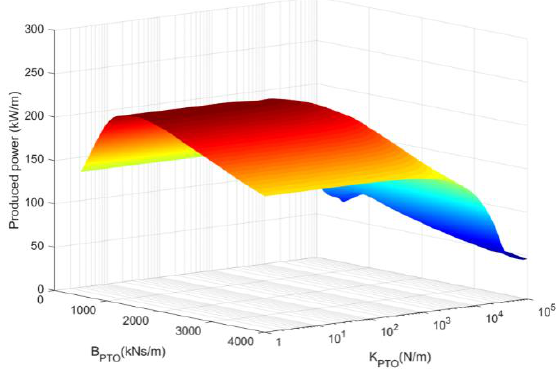
Figure 6. Mutual effect of different K PTO and B PTO values on the WEC performance. Figure 6. Mutual e ff ect of di ff erent K PTO and B PTO values on the WEC